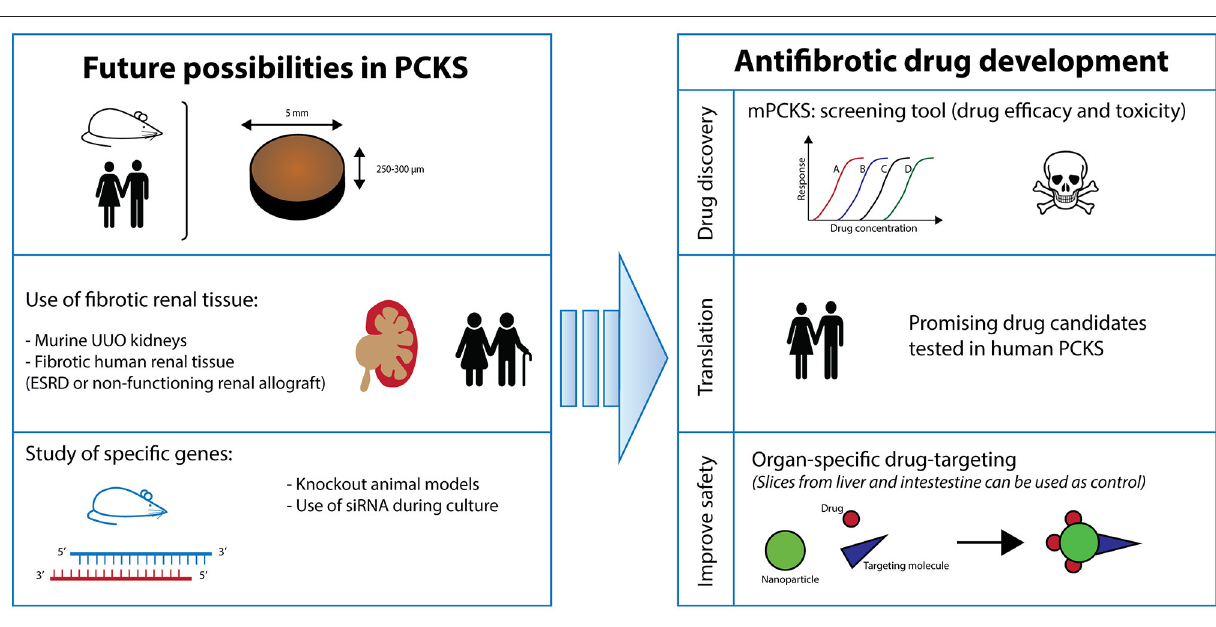
2017). Our study confirmed the antifibrotic effect of